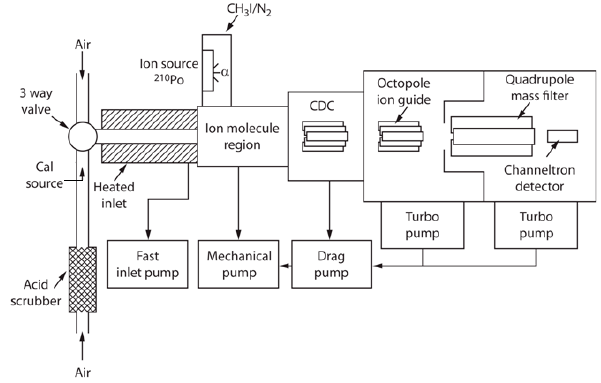
Fig. 1. Schematic of chemical ionization mass spectrometer (CIMS) used in this study. Arrows indicate direction of gas flow. Dimen- sions are not to